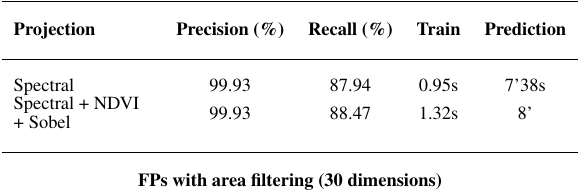
FPs with area filtering (30 dimensions) Gray values (AP)